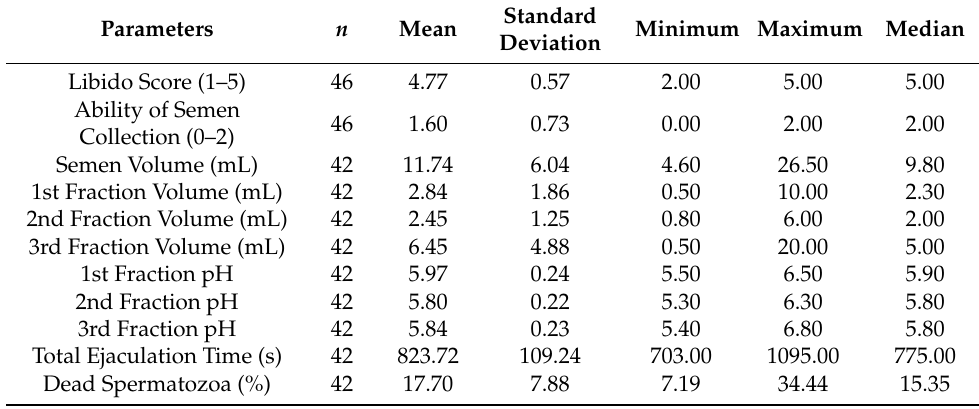
Table 2. The average value of behavioral, spermatological and thermographic parameters.